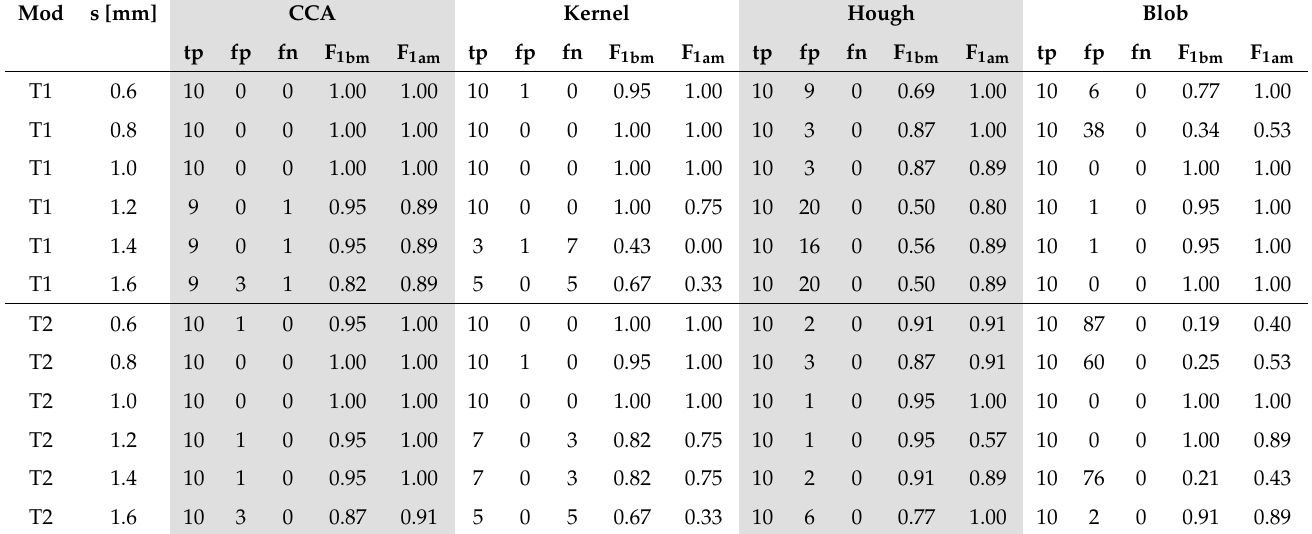
Table 1. Classification results, sorted by image modality (mod), voxel size (s) and method (Connected Component Analysis (CCA), kernel-based (kernel), circular Hough transform (Hough), blob detection related (blob)). Detected spheres where classified as true positive (tp) if the Euclidean distance between the detected centroid and the ground-truth measurement satisfies a threshold of 14mm, otherwise they were classified as false positive (fp). Spheres present in the ground truth measurement but not detected by the algorithms were classified as false negative (fn). This classification task was conducted before applying the marker model. The according F 1 score was calculated before (F 1bm ) and after (F 1am ) application of the marker model (the marker must contain two spheres at a certain distance). F 1 scores close to 1 are better, see Equation